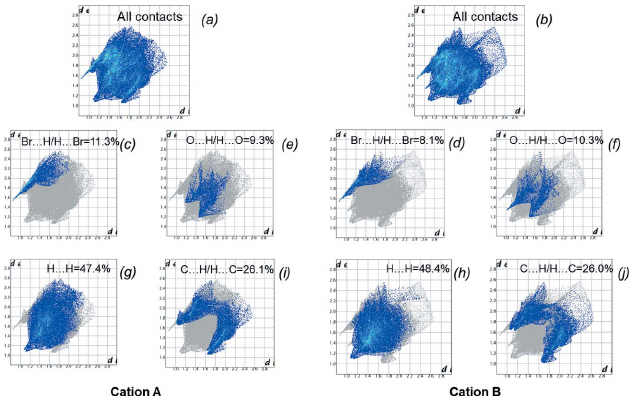
Figure 5 Contributions of interactions of different types to the total Hirshfeld surface of cations A and B in the crystal structure of AmBr hemihydrate.